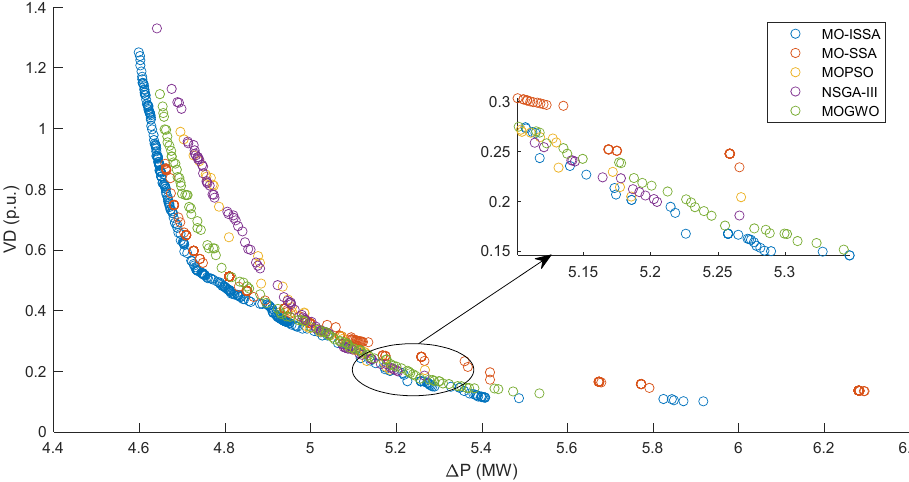
Figure 8. Pareto fronts obtained for IEEE 30-bus system.